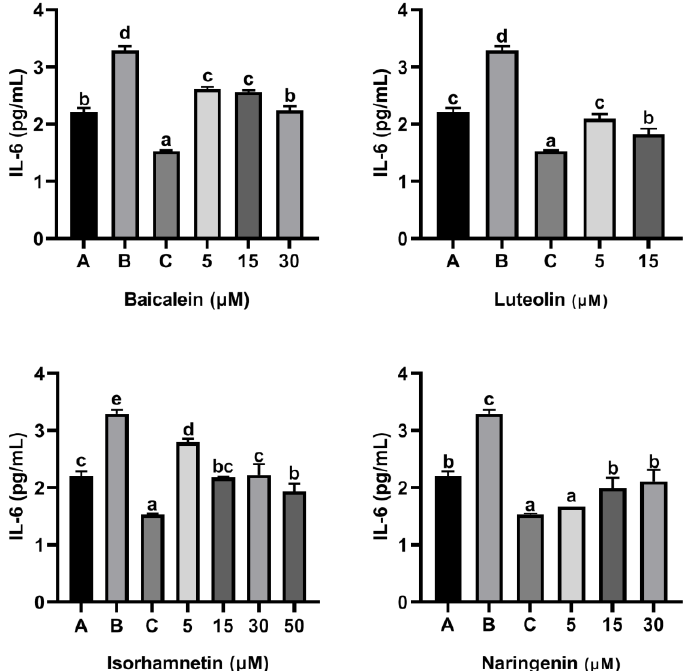
Figure 9. Effect of four flavonoids on the release of IL-6 from Caco-2 cells induced by ω -5 gliadin- derived peptide P4. A (blank group): only Caco-2 cells; B (control group): 150 µ g/mL ω -5 gliadin- derived peptide P4+Caco-2 cells; C (positive control group): 10 nM Dexamethasone+Caco-2 cells. Note: different letters indicate significant differences between groups ( p < 0.05).